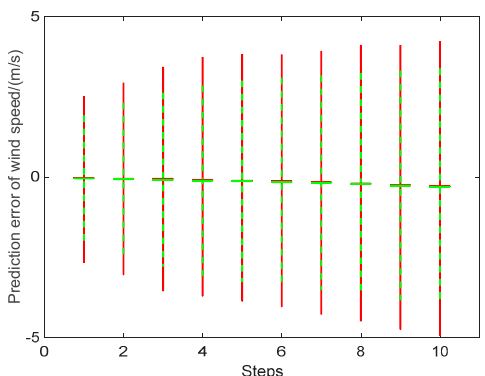
Figure 13. Error statistic of ten-step wind speed prediction for KDE and Gaussian methods. (Red line: KDE; Green dotted line: Gaussian).